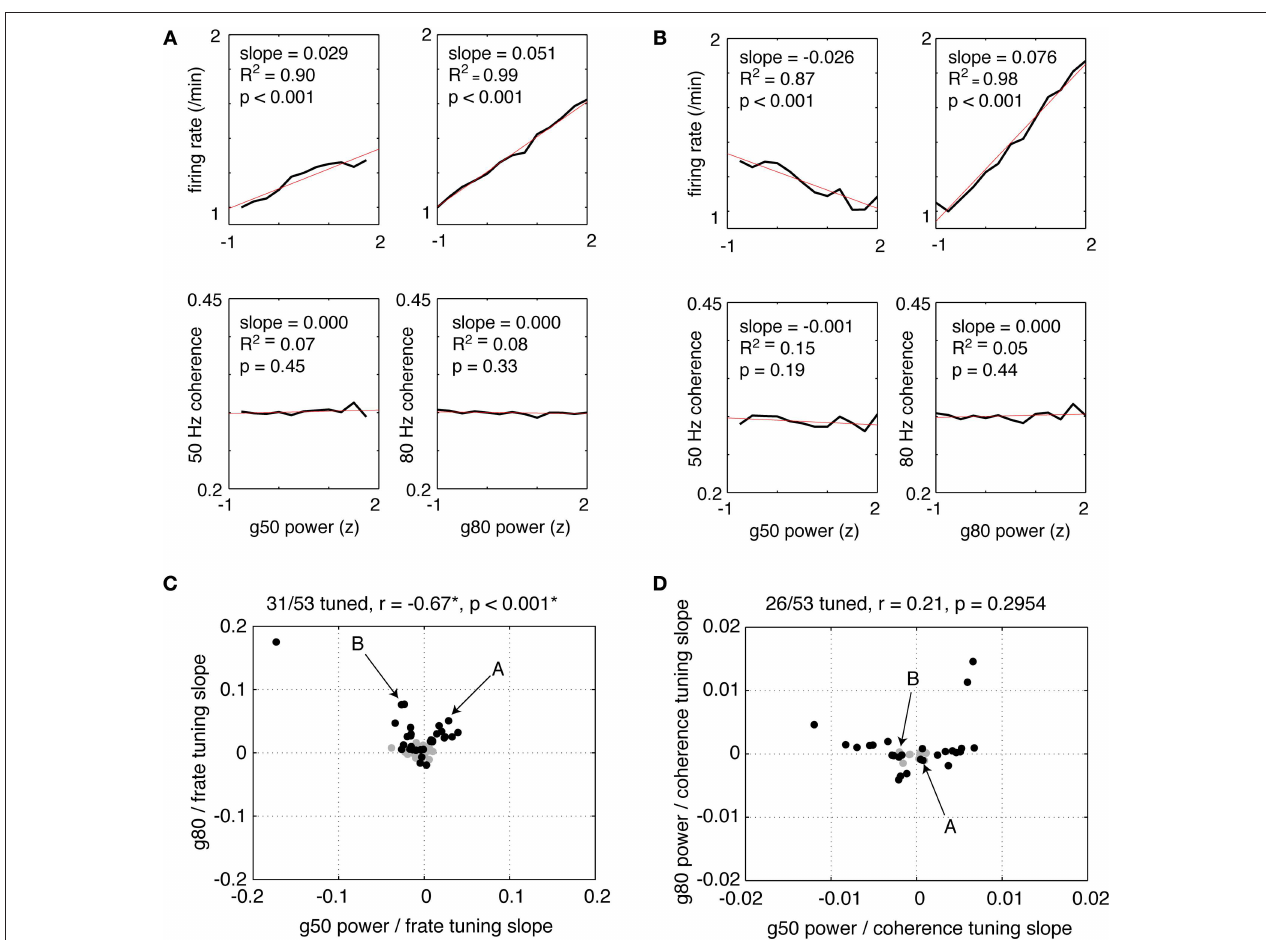
FIGURE 13 | Putative fast-spiking interneurons (FSIs) showed a variety of fi ring rate tuning relationships to gamma-50 and gamma-80 power. (A,B) Firing rate tuning (top row) and coherence tuning (bottom row) to gamma- 50 power (left column) and gamma-80 power (right column) for two example FSIs. Firing rates were normalized to each neuron’s minimum fi ring rate of its raw tuning curve. Power was z -scored within sessions in order to allow comparison of tuning curves on the same scale. The neuron in (A) increased its fi ring rate with increasing gamma-50 and gamma-80 power, by a factor of 1.5 or more for the latter, while the neuron in (B) decreased its fi ring rate with increased gamma-50, but increased fi ring with stronger gamma-80. For neither neuron did